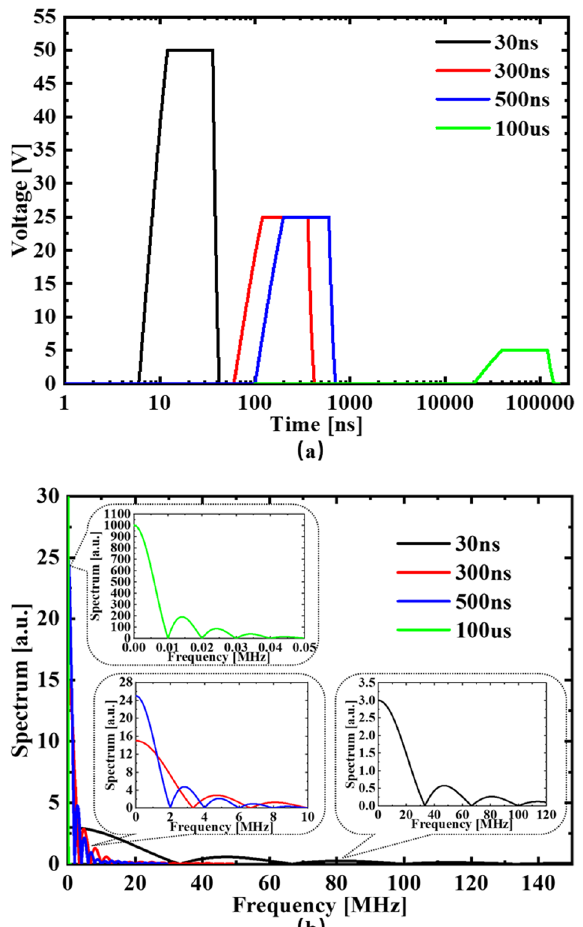
Figure 2. The applied voltage in ( a ) time domain and ( b ) frequency